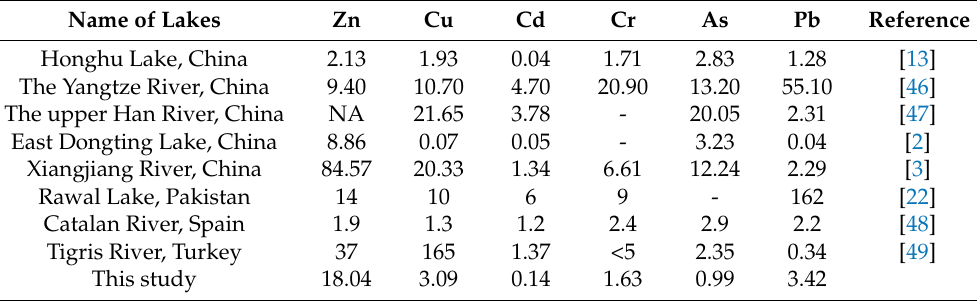
Table 4. Summaries of measured trace elements in freshwater from freshwater lakes at home and abroad ( µ g/L).